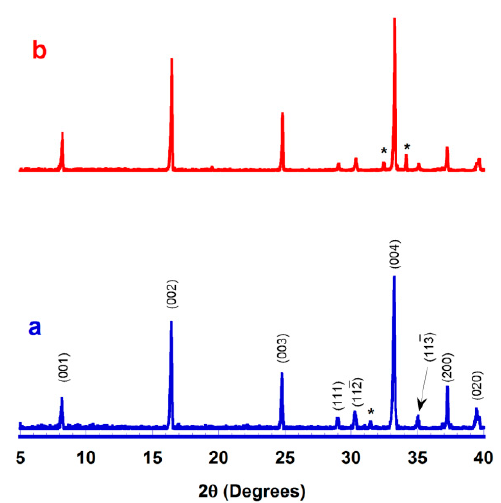
Figure 4. XRD patterns obtained on the surface of sintered materials produced by attrition milling and sintered for 4 h ( a ); ball milling ( b ). * indicates the reflections of Ca 3 Co 2 O 6 + δ phase.